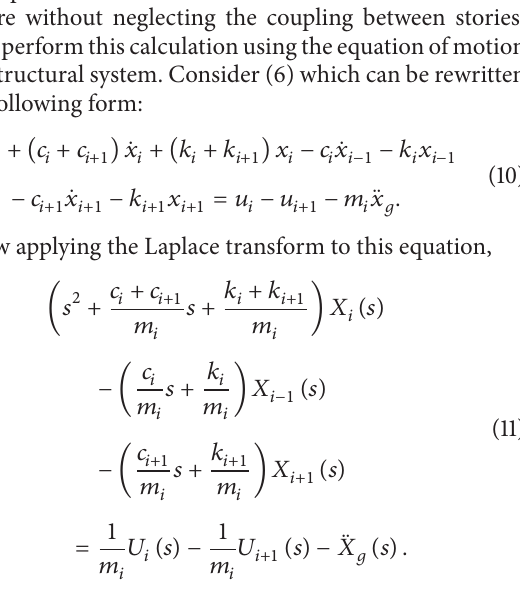
dimension (𝑛 × 𝑛) , 0 null matrix of dimension (𝑛 × 𝑛) , and 0 null vector of dimension (𝑛 × 1)